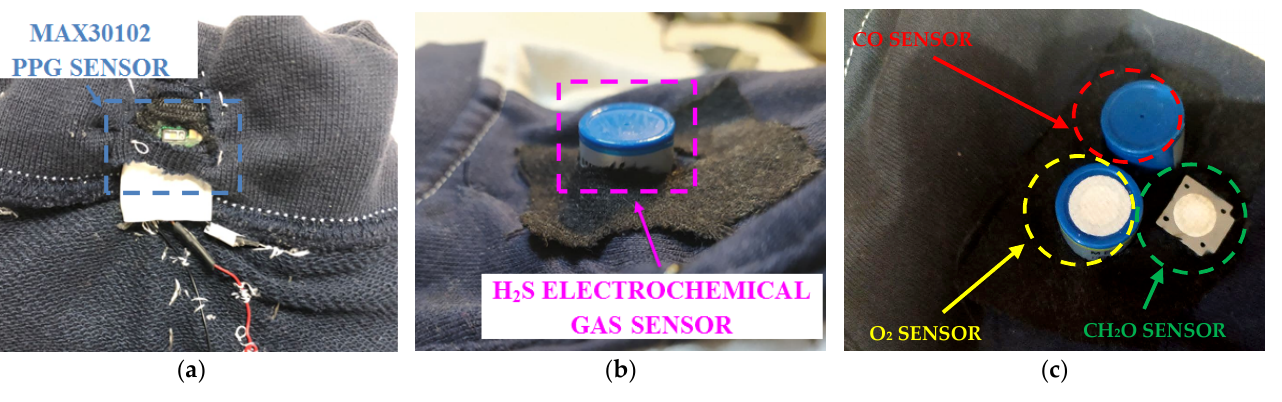
Figure 6. Details of the MCU board fixed on the garment by plastic support, with the connections terminated by clip button ( a ); plastic protective cover ( b ).